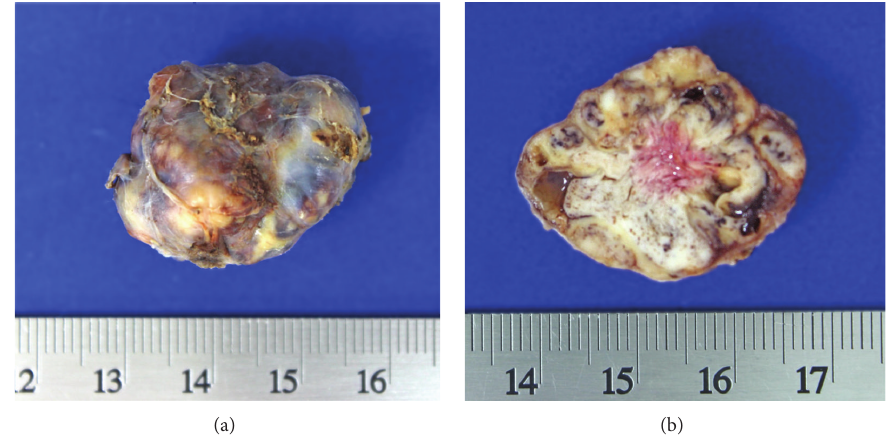
Figure 4: (a) Right inferior parathyroid gland. (b) Hemorrhagic and cystic areas.